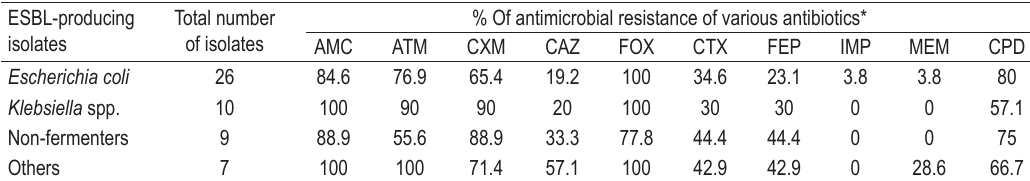
TABLE 2. Antimicrobial resistance of beta‑lactamase‑producing isolates collected from environmental samples ESBL‑producing